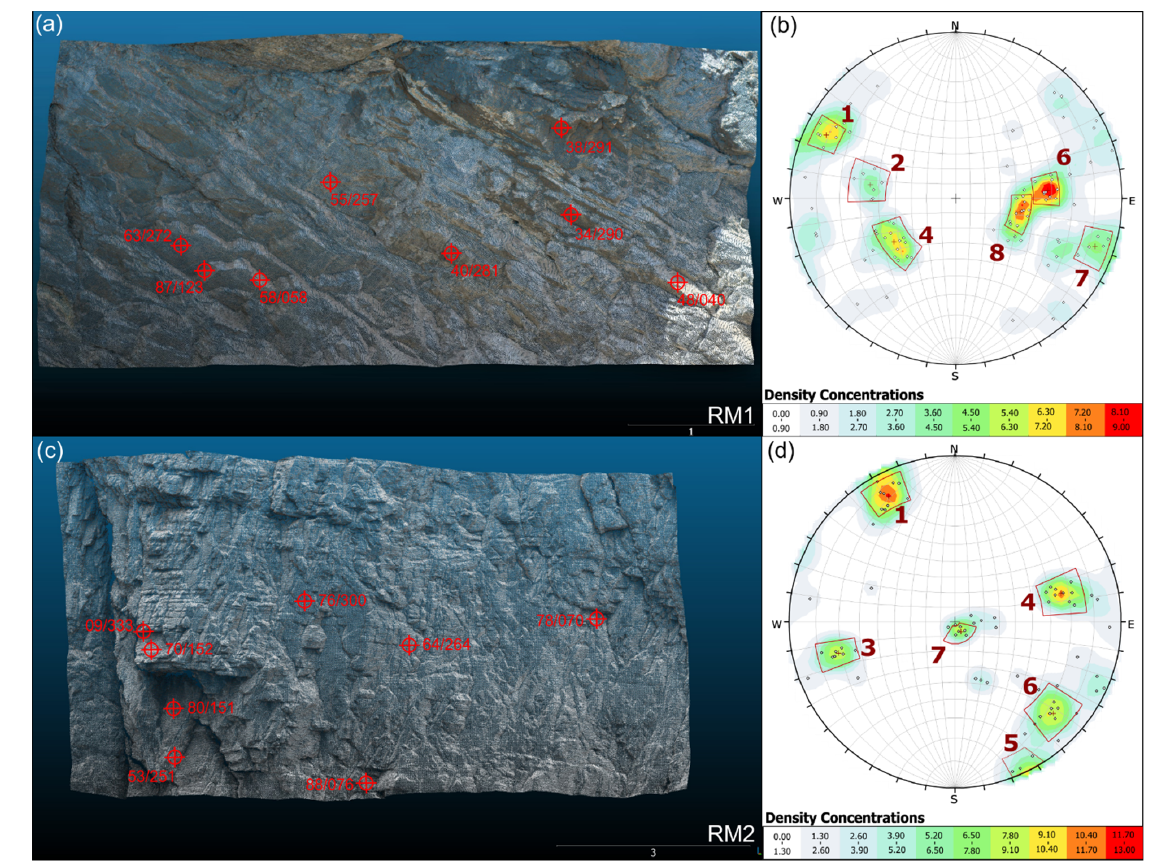
Figure 5. Biased discontinuity survey from dense point clouds of RM1 ( a ) and related stereogram ( b ), RM2 ( c ) and related stereogram ( d ). Table 3. List of discontinuity sets extracted according to the biased ISRM criterion.